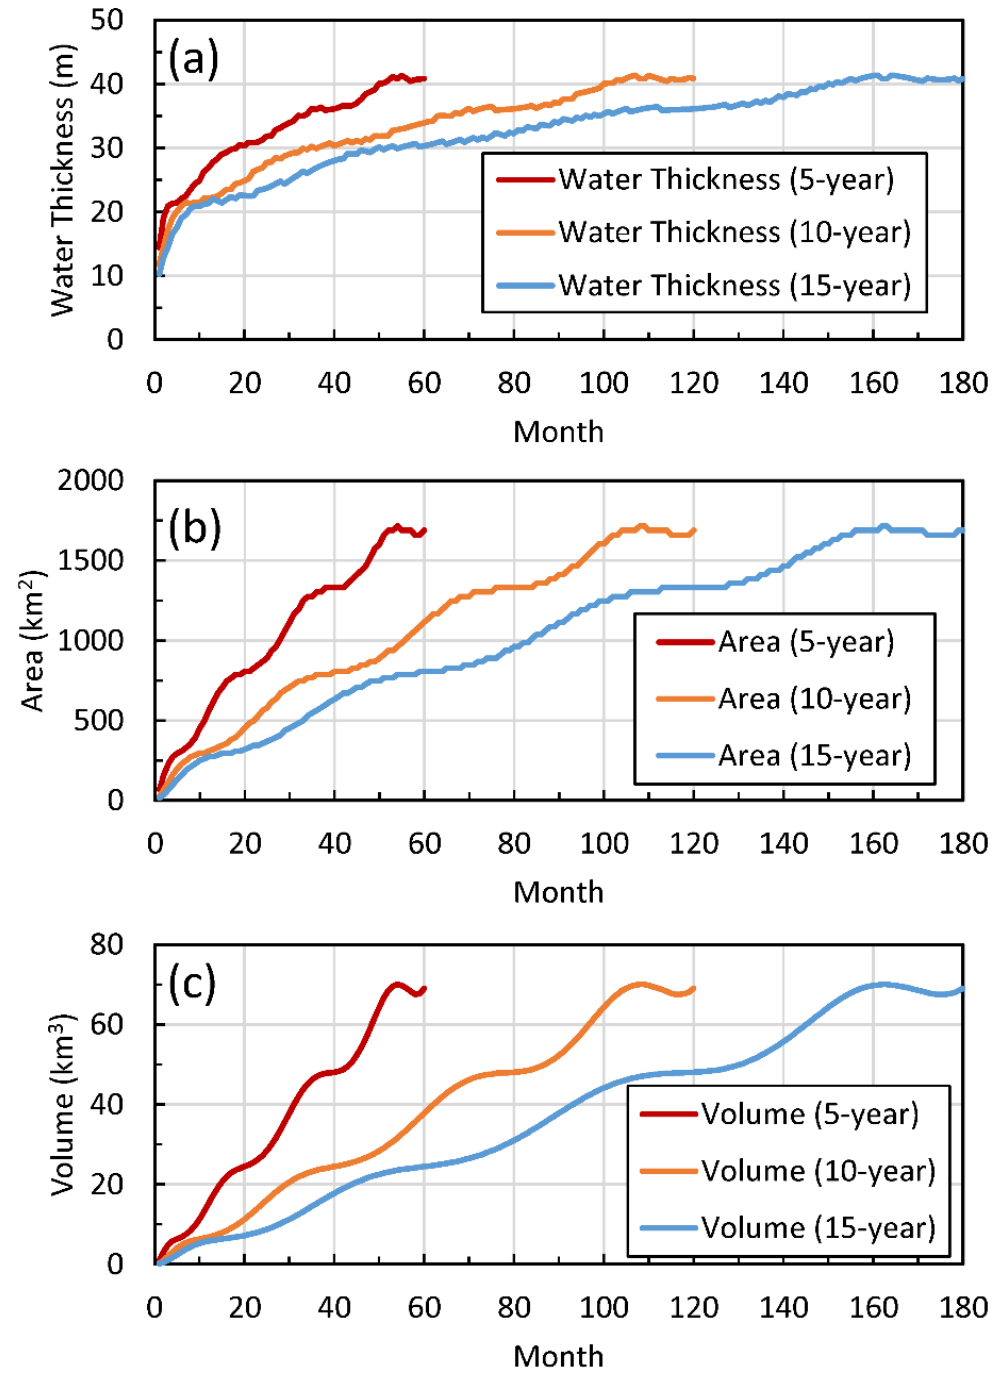
Figure 3. Monthly simulation of the GERD reservoir ( a ) water thickness, ( b ) area, and ( c ) volume, based on 5-, 10-, and 15-year filling strategies.